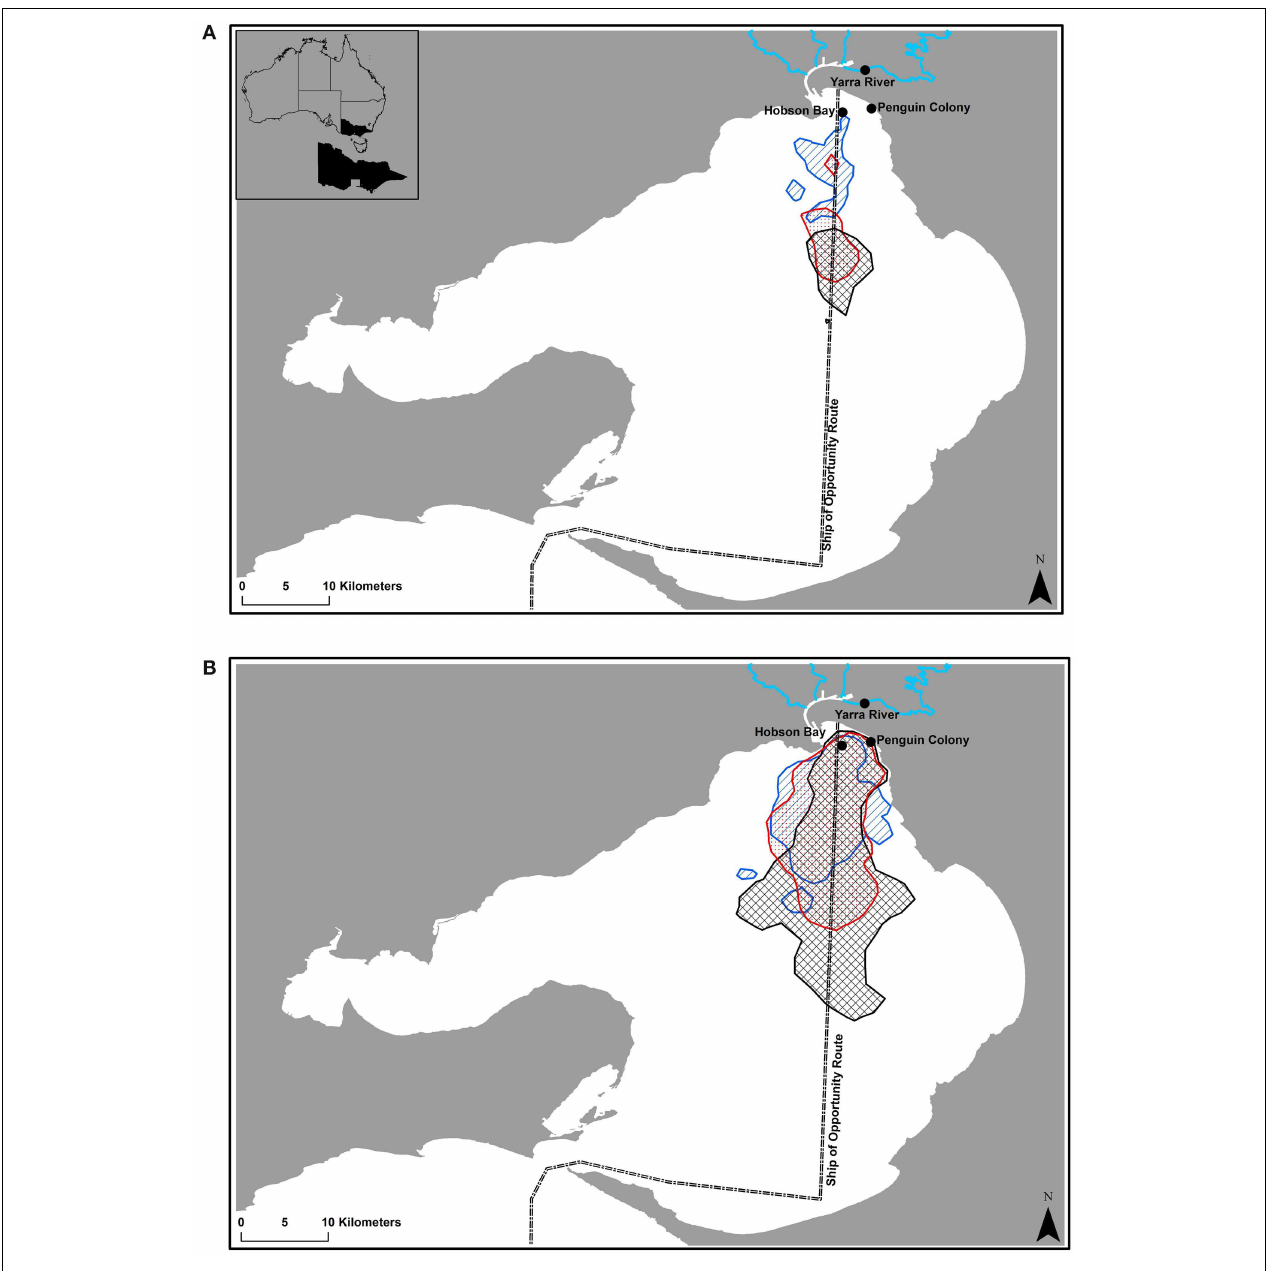
FIGURE 1 | (A) Core-range kernel utilization distribution (KUD) plots of the combined core-ranges (50% KUD) of 11penguins in 2008 (blue), 5 penguins in 2011 (red) and 11 penguins in 2012 (black) in relation to the Ship of Opportunity route that transverses Port Phillip Bay. (B) Home-range kernel